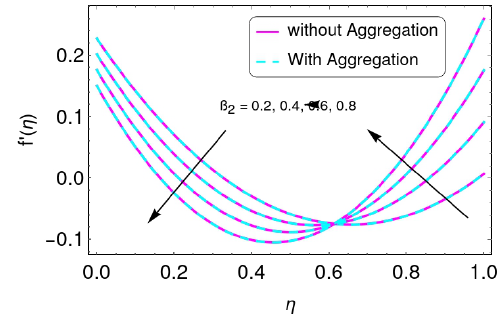
Figure 5. Characteristics of ß 2 for f (cid:48) .